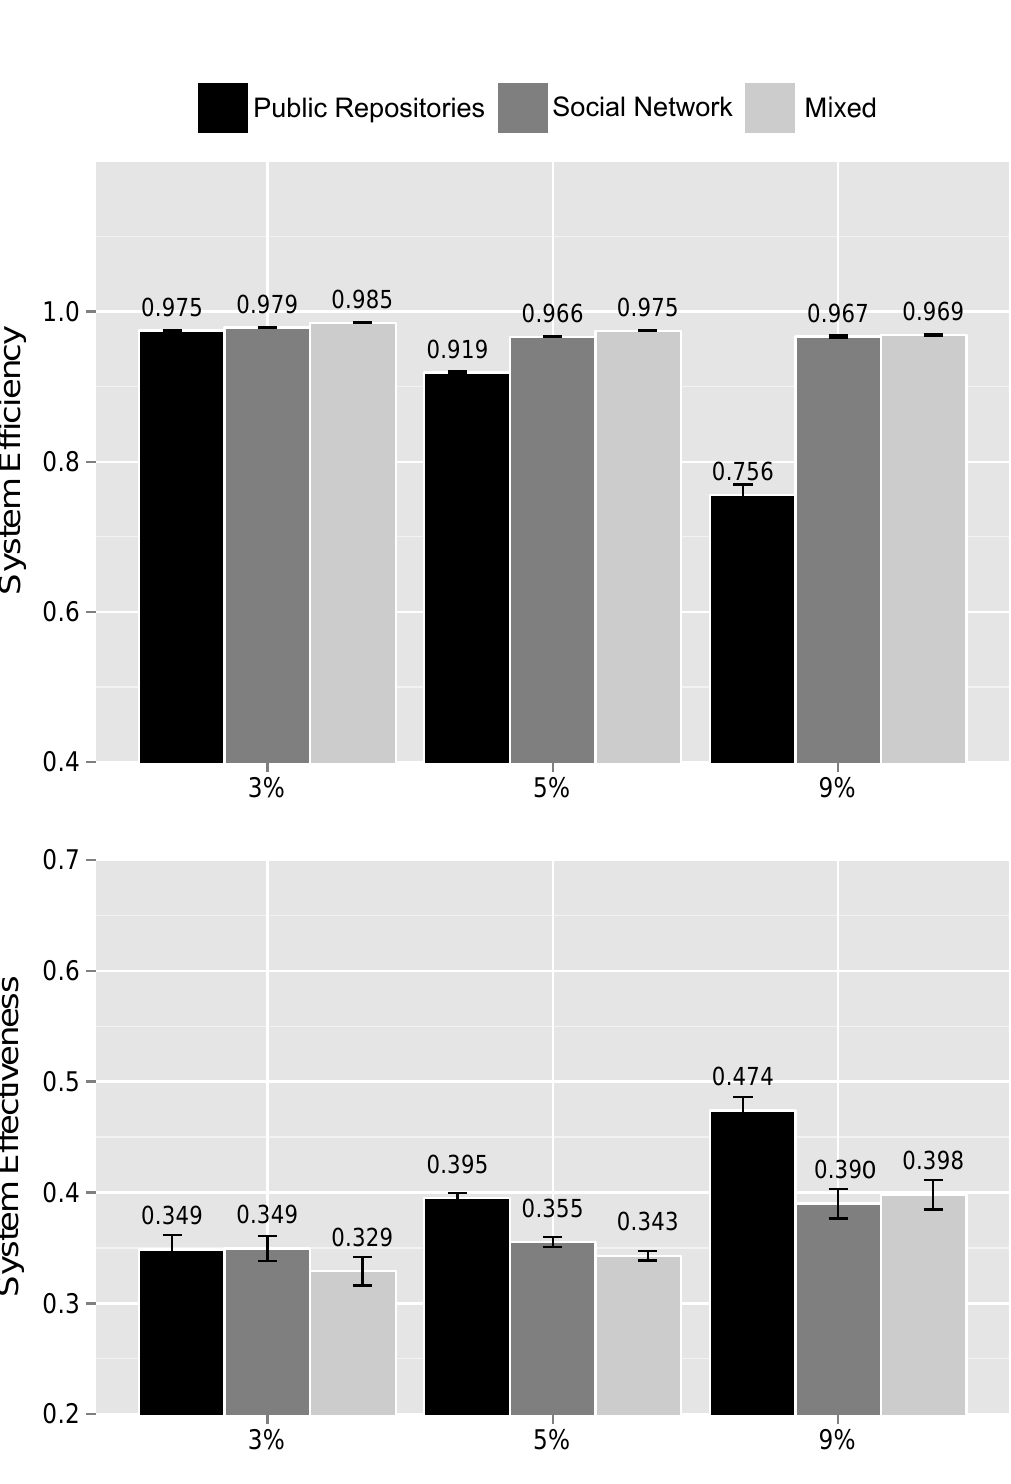
Figure 3: Effects of public repositories, social network, and mixed information on system efficiency and effectiveness (with a varied probability of knowledge transformation) in the knowledge transformation model. The maximum efficiency and effectiveness in both models are normalized to